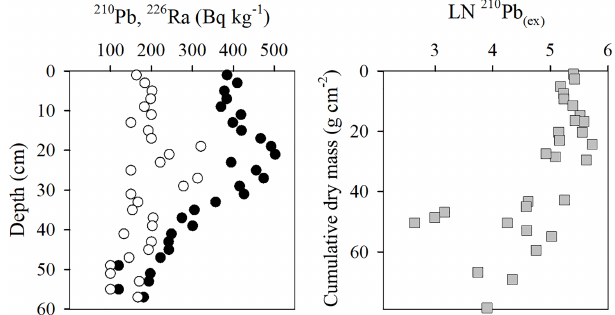
Figure 4. Lead-210 (black circles) and 226 Ra (white circles) pro- files against depth. Grey squares represent the 210 Pb ( ex ) profile vs. cumulative dry mass.